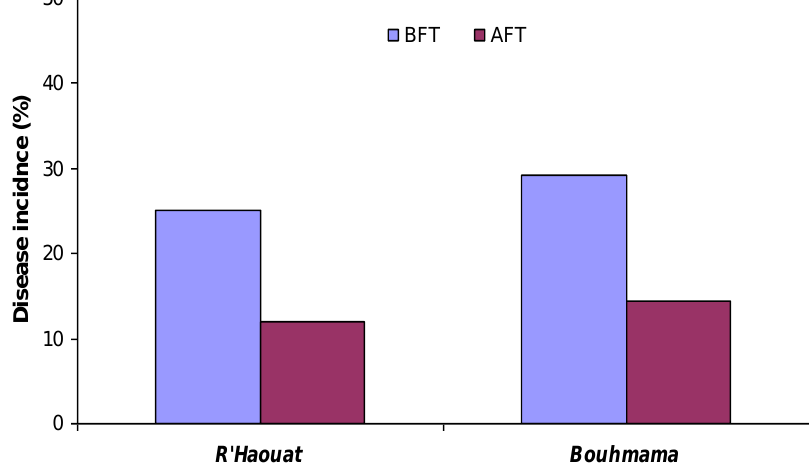
Figure 1. Apple scab incidence before (BFR) and after (AFT) leaf litter treatment by invert emulsions.